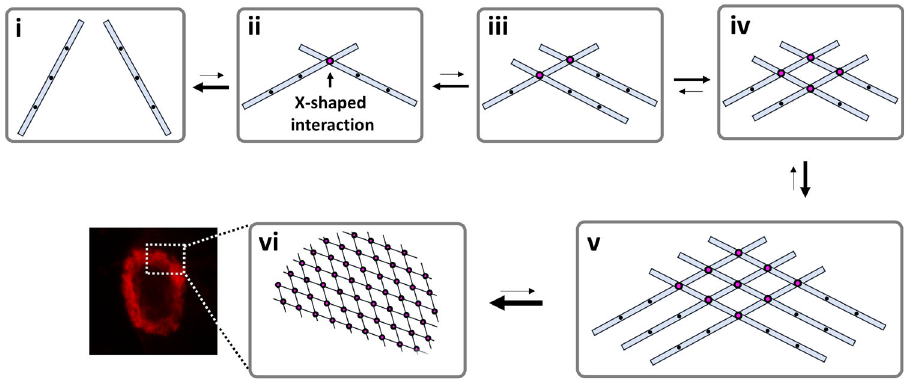
Fig. 7 The proposed mechanism for the aggregation of lamin fi laments by the S143F mutation. A hypothetical mechanism is proposed to explain the mutual ampli fi cation of Phe143-triggered hydrophobic interactions. The two linear fi laments form the reversible X-shaped interaction on the Phe143 sites (magenta circle) at low af fi nity (i, ii). Another linear fi lament is joined to the existing fi laments at a similar af fi nity on the Phe143 site near the preoccupying site, resulting in similar binding sites for recruiting the other lamin fi laments (iii). Finally, the fourth fi lament is bound to the two Phe143 sites simultaneously, resulting in a mutual binding platform at a higher binding af fi nity (iv). The equilibrium is increasingly shifted to the association as more fi laments are recruited. All linear fi laments make contacts on more Phe143 sites (v), resulting in local aggregation on the nuclear membrane Crystallization, structure determination, and analysis . The S143F mutant lamin Puri fi cation of the recombinant proteins . Transformed E. coli cells were cultured 300 fragment (8 mg/ml) was crystallized in a precipitation solution containing in 4 L of Terri fi c broth or M9 medium supplemented with L-( + )-selenomethionine at 37°C. Protein expression was induced by 0.5 mM IPTG at 30 °C. After the cells were harvested by centrifugation, they were resuspended in lysis buffer containing fragment were brie fl y dipped in a cryoprotectant solution containing 20% galactose 20mM Tris-HCl (pH 8.0), 150mM NaCl, and 2mM 2-mercaptoethanol. The cells and fl ash-frozen in a nitrogen stream at − 173 °C. The diffraction datasets were were disrupted using a continuous-type French press (Constant Systems Limited, collected using an Eiger 9M detector at Beamline 5C at PLS (Pohang, Republic of Daventry, UK) at 23 kpsi pressure, and the cell debris was removed by cen- Korea) and were processed with the HKL2000 package 37 . The structure of the trifugation at 19,000 × g for 30 min at 4°C, after which the supernatant was loaded onto cobalt-Talon af fi nity agarose resin (Qiagen, The Netherlands) in lysis buffer. S143F mutant lamin fragment was determined using the molecular replacement The target protein was eluted with lysis buffer supplemented with 250 mM imi- method with MOLREP in the CCP4 package 38 . The structure of the wild-type dazole. The eluate was treated with TEV protease to cleave the hexaHis-tag and was lamin 300 fragment (PDB code: 6JLB) was split into two parts (residues 67 – 145; then loaded onto a HiTrap Q column (GE Healthcare, USA). A linear gradient of 146 – 240) and was used as the search model for molecular replacement. The increasing NaCl concentration was applied to the HiTrap Q column. The fractions crystals belonged to space group P 4 1 22 with unit-cell dimensions of a = 123.8Å that contained the protein were applied onto a size exclusion chromatography and c = 458.5Å (Table 1). The programs COOT and PHENIX were used for model column (HiLoad Superdex 200 26/600 column; GE Healthcare, California, USA) building and re fi nement 39,40 . Statistical information regarding data collection and pre-equilibrated with lysis buffer. processing is presented in Table 1. Structural analysis was performed using COOT,